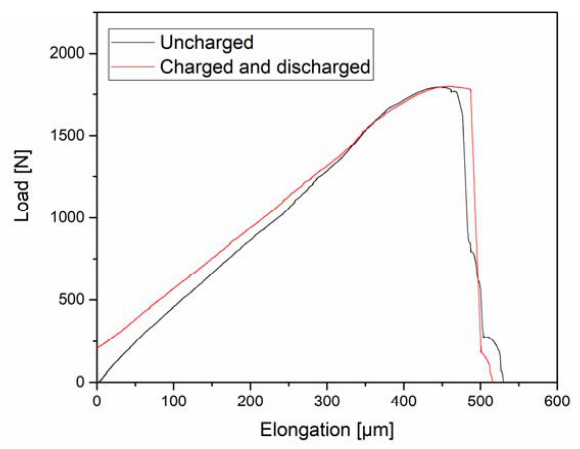
Figure 12. Load-elongation curves of an uncharged CP 1200 steel sample and one initially charged for 4 h and tested after discharging for additional 12 h in